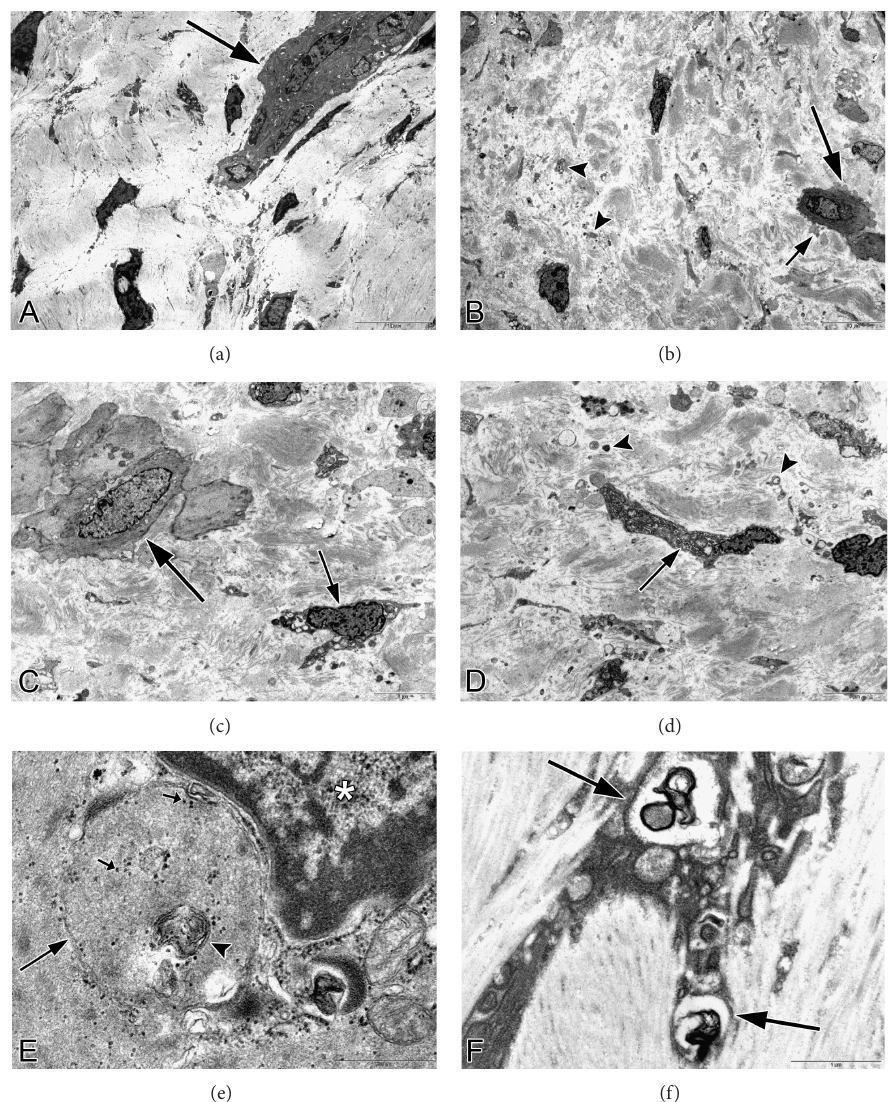
Figure 18: Ultrastructure of inanosis and reclamation. Electron microscopic examination of fibrotic areas in fibroids provides even more dramatic evidence of shrunken myocytes, widely spaced within the fibrotic stroma. In (a), there is a cluster of cells which have retained some cytoplasm (arrow) and provide a frame of reference for the small, shrunken cells. In (b), a cell in the lower right (long arrow) exhibits cytoplasmic budding, with one or two of these knob-like fragments apparently pinching off from the cell membrane (small arrow); we refer to this as decapitation membrane budding. Note that the loose, watery stroma contains numerous particles of cellular debris (arrowheads), withoutanyevidenceofinflammatorycellinfiltrateorphagocytosis.In(c),theshrunkencellinthelowerright(shortarrow)contrastswiththe less atrophic cell in the upper left (long arrow). The cytoplasm of the shrunken cell contains vacuoles, lysosomes, and degenerating organelles with few remaining myofilaments. The slender, atrophic cell in the center of the fibrotic field in (d) has retained its shape and endoplasmic reticulum (arrow), but has lost most of its myofilaments. The surrounding matrix contains abundant cellular debris (arrowheads), imparting a junkyard appearance. In (e), there is an autophagosome (long arrow) containing ribosomes (short arrows) and membranous debris which could be of endoplasmic reticulum origin (arrowhead). The remainder of the contents of the autophagosome resembles the adjacent cytosol and probably consists of degenerated myofilaments. The nucleus (asterisk) is in the upper right of the image. The cell in (f) exhibits two doublemembranedautophagosomes(arrows)containingelectron-densemembranousdebris.Originalmagnificationof(a):1700x,(b):1250x, (c): 2550x, (d): 2550x, (e): 43,000x, and (f):